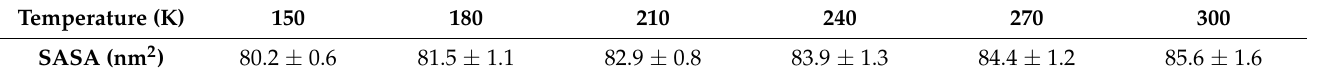
Table 2. SASA of SN0 at different temperatures; statistics on 1900 frames with standard deviation.